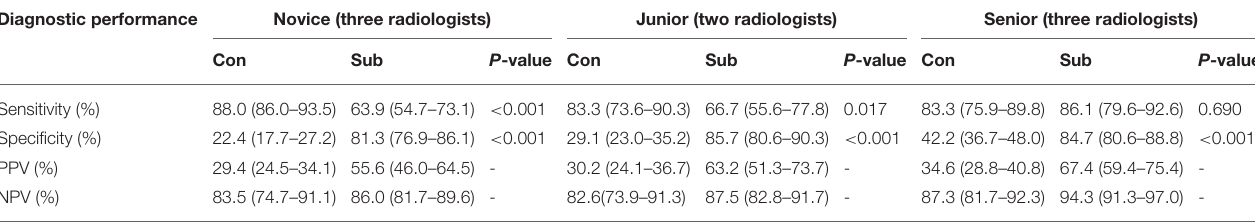
TABLE 3 | Diagnostic performance in detecting obstructive CAD for novice, junior, and senior radiologists with conventional or subtraction CCTA.